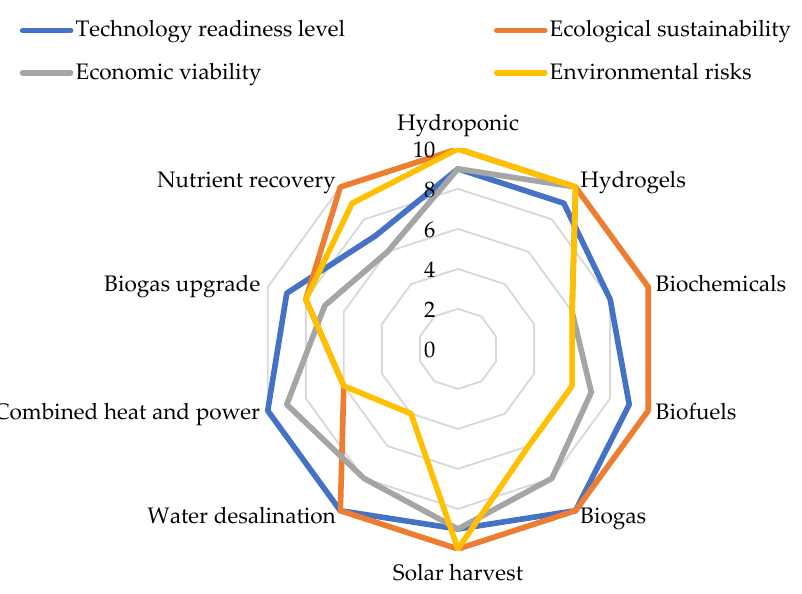
Figure 9. Attributes evaluation of processes and products of proposed circular economy model.